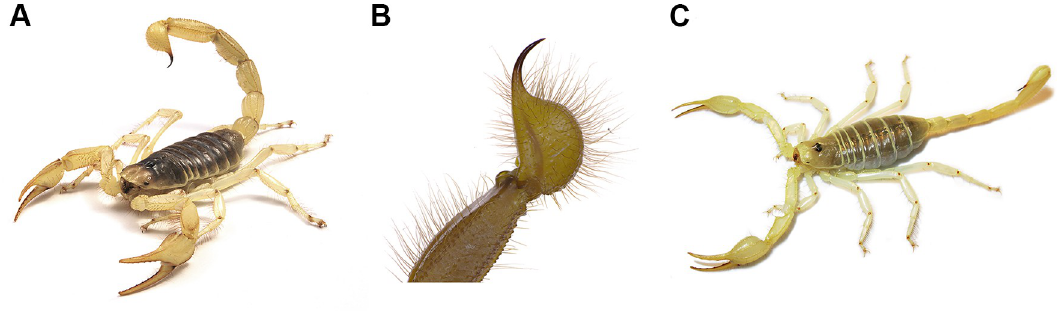
Fig 1. Images of H . arizonensis and S . mesaensis . Images of A, B) H . arizonensis with an enlarged view of its telson and stinger, and C) S . mesaensis